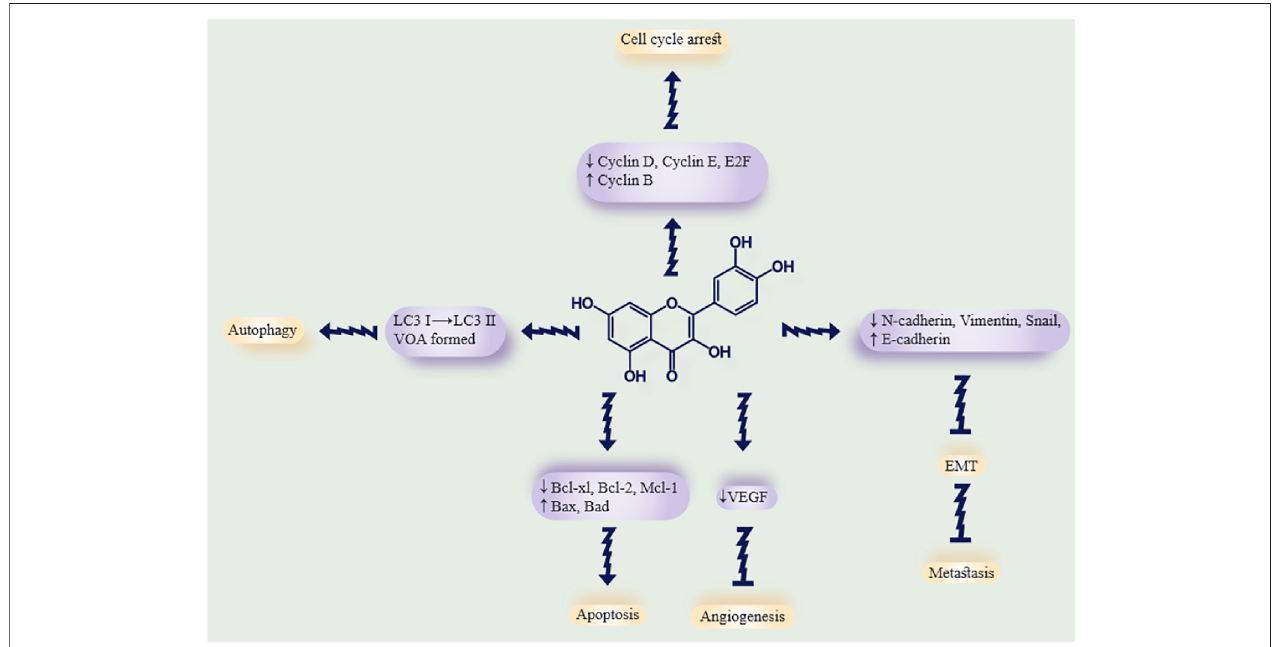
FIGURE1| Summaryoftheantitumorpropertiesofcurcumin.Theeffectsofquercetinontumorcellsandthepossiblemoleculartargetsforeacheffect.Thearrows showquercetinantitumormechanisms,whilethebluntlinesshowtumor-suppressiveeffects.Downwardsorupwardsarrowsindicatedownregulationorupregulationof molecular